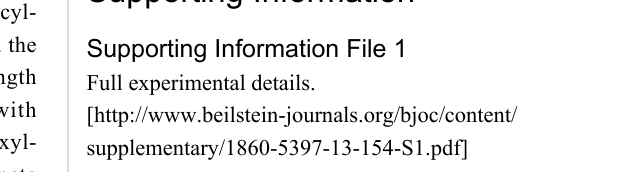
Figure 7: C6 ester derivative 10